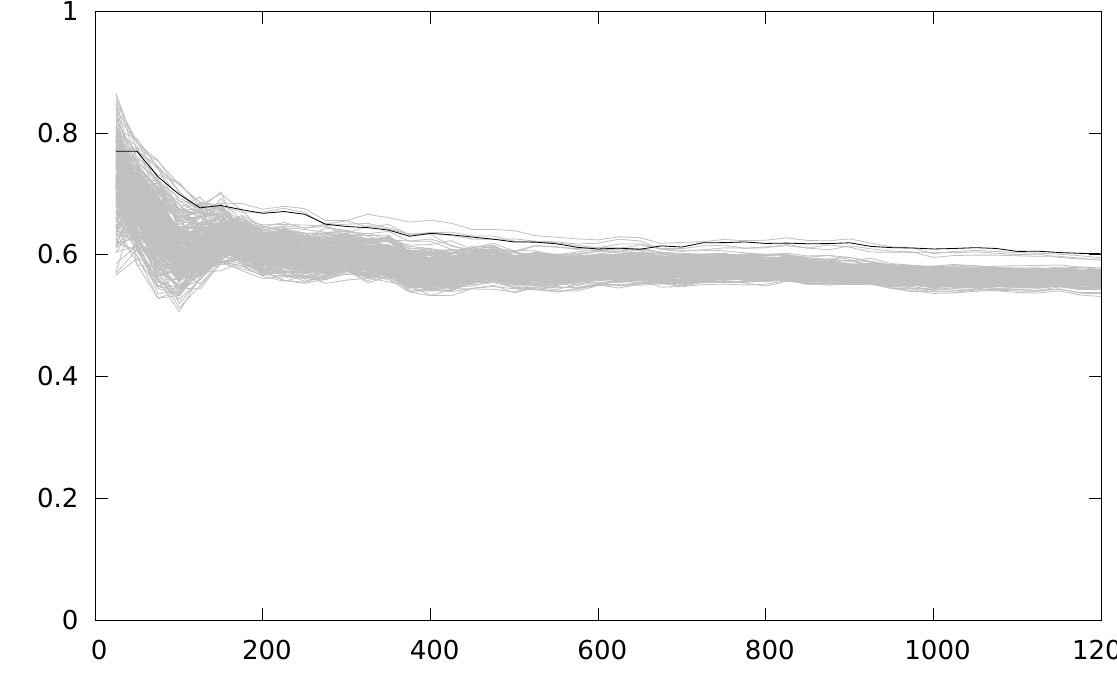
Figure 7. Maximum correlation for different key guesses vs . number of power traces with a partial loop unrolling of 2 iterations with MSPSim with 5 cycle window